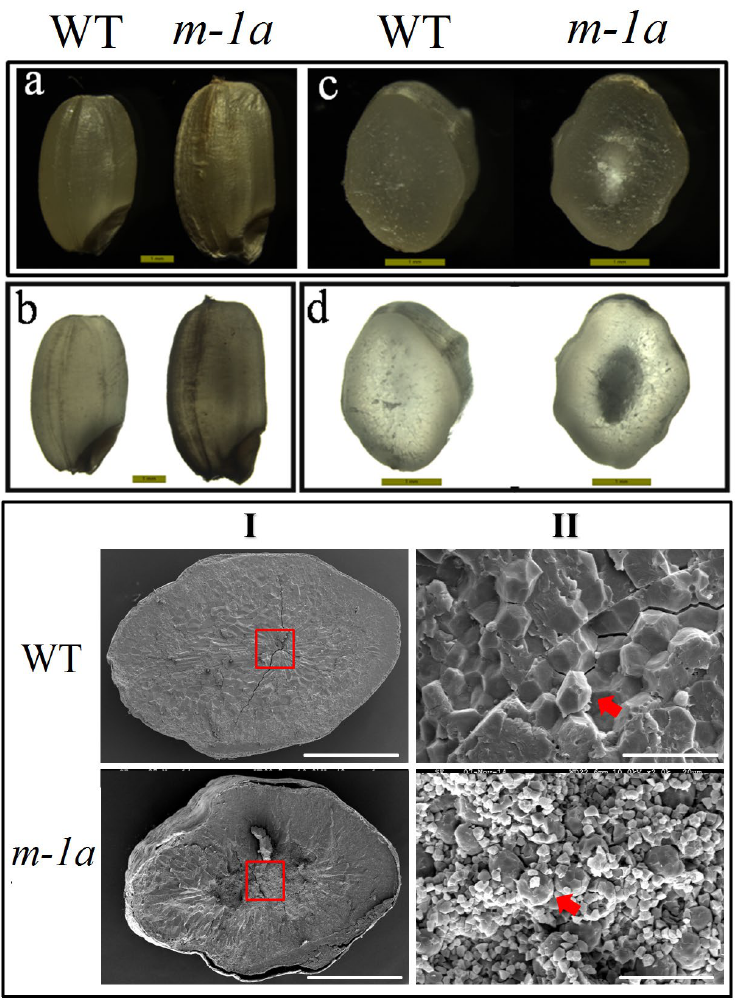
Figure 4. Comparison of the structures in m-1a and wild-type seeds. ( a ) Skin structure of brown rice grains in the light. ( b ) Cross-sections of brown rice grains in the light. ( c ) Skin structure of brown rice grains in transmission light. ( d ) Cross-sections of brown rice grains in transmission light. ( I) Cross-sections of brown rice grains in scanning electron microscopy images. ( II ) Starch structure of endosperm center in scanning electron microscopy images. ( a – d ) Bar = 1 mm. ( I ) Bar = 1 mm. ( II ) Bar = 20 μm. WT = wild-type plants (‘Zhonghua 11’).